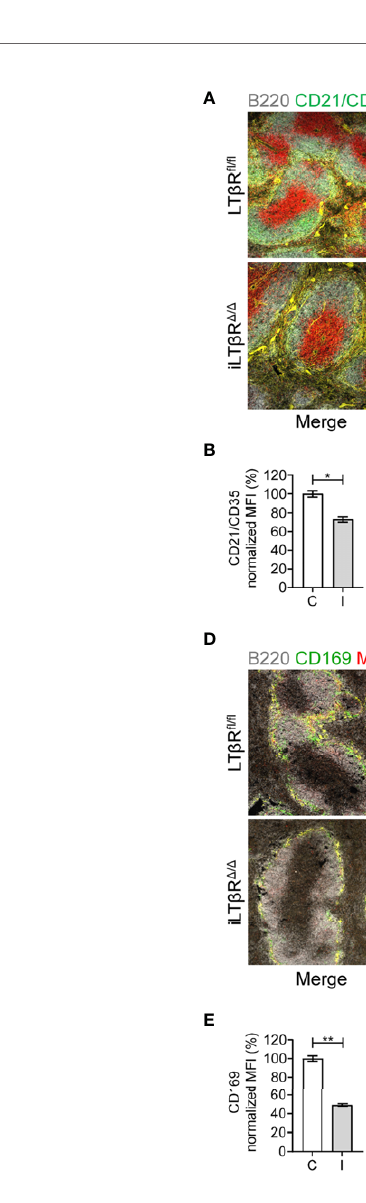
FIGURE 2 | Impact of inducible LT b R inactivation in adulthood on spleen microarchitecture. LT b R fl / fl (C) and iLT b R D / D (I) mice were treated with TAM by oral gavage one month before analysis. (A) Representative confocal images of frozen spleen sections stained with antibodies against B220 (white), CD21/CD35 (green), CD3 (red) and ER-TR-7 (yellow). (B) Quanti fi cation of FDCs. n=4 per group. (C) Expression of splenic CXCL13, CCL19, and CCL21 mRNA determined by qPCR (n=4-8). (D) Representative confocal images of frozen spleen sections stained with antibodies against B220 (white), CD169 (green), MAdCAM-1 (red) and SIGNR1 (yellow) to analyze the marginal zone structure. (E) Quanti fi cation of CD169, MAdCAM-1 and SIGNR1 expressing cells. n=4 per group. Scale bars = 100 m m for all images. Data shown are means ± SEM. Bars show the mean, symbols represent individual mice. Data is from one of two experiments with similar results. Signi fi cance was determined using Mann-Whitney or Unpaired t-test. Not signi fi cant (ns, p > 0.05), *p < 0.05, **p <